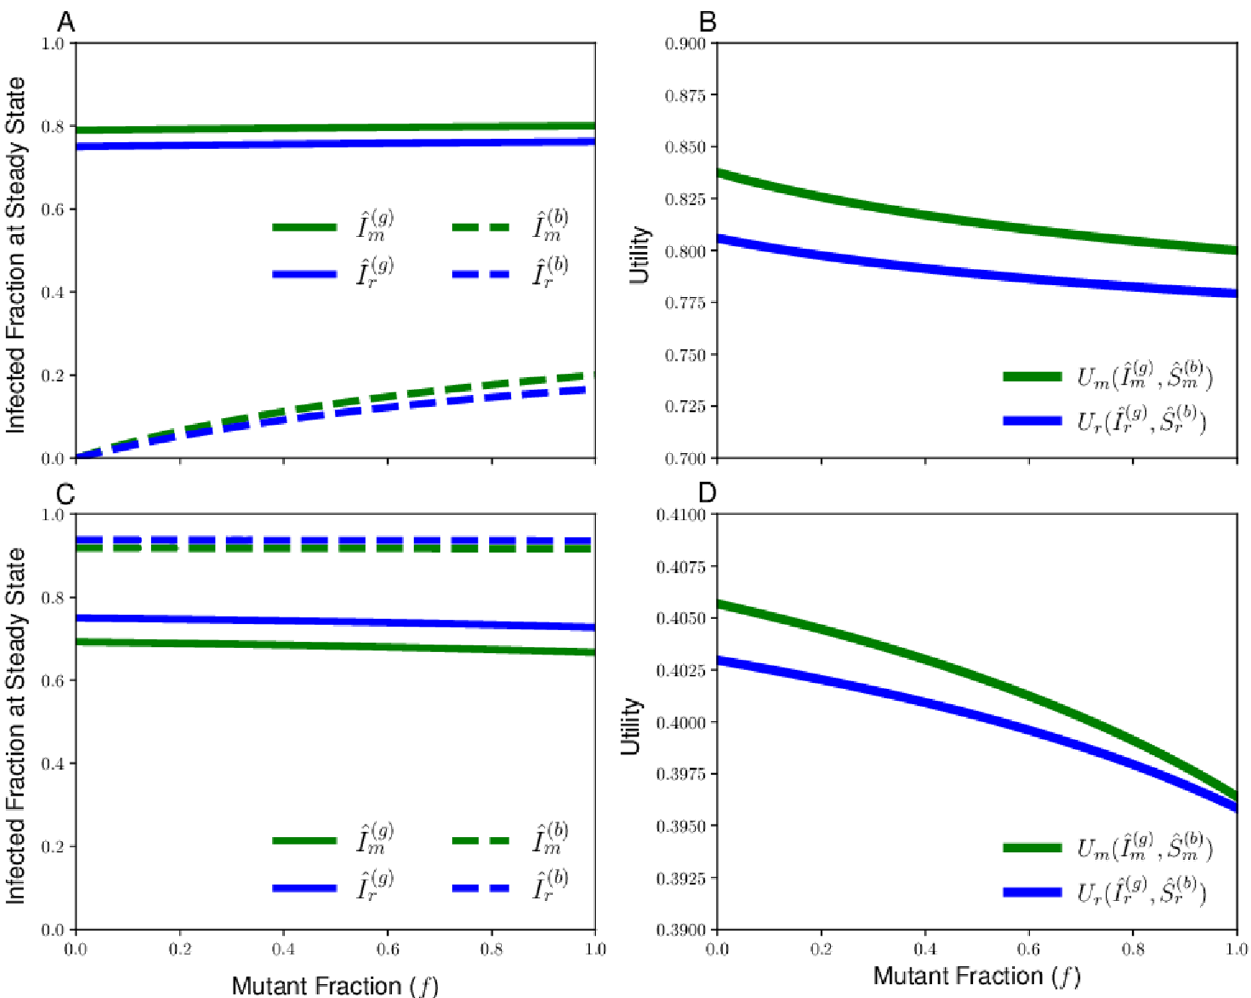
Fig 2. Sample contagion equilibria and Cobb-Douglas utility achieved by resident and mutant strategies as a function of the fraction of individuals following the mutant strategy f . We consider a resident with reproduction number R ð g Þ bad contagion for the cases of relative infectiousness and mutant reproduction number c = 0.25, R ð g Þ Douglas utility U r ( f ) and U m ( f ) achieved at contagion equilibrium for individuals following resident and mutant strategy, will parameters c = 0.25, R ð g Þ ( B ) or c = 4, R ð g Þ ¼ 3 ( D ). For both cases, we use a Cobb-Douglas utility function with weight parameter α = 0.75. In both cases, the utility of the mutant type m (green curve) always exceeds the utility of the resident type (blue curve), and the replicator equation will favor fixation to an all-mutant